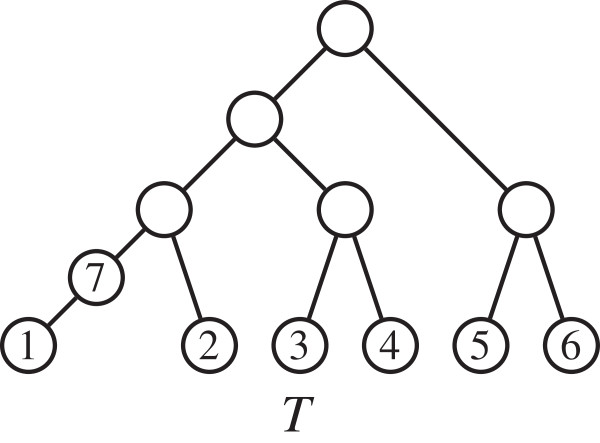
Three non-isomorphic trees with the same vectorφ~(T).